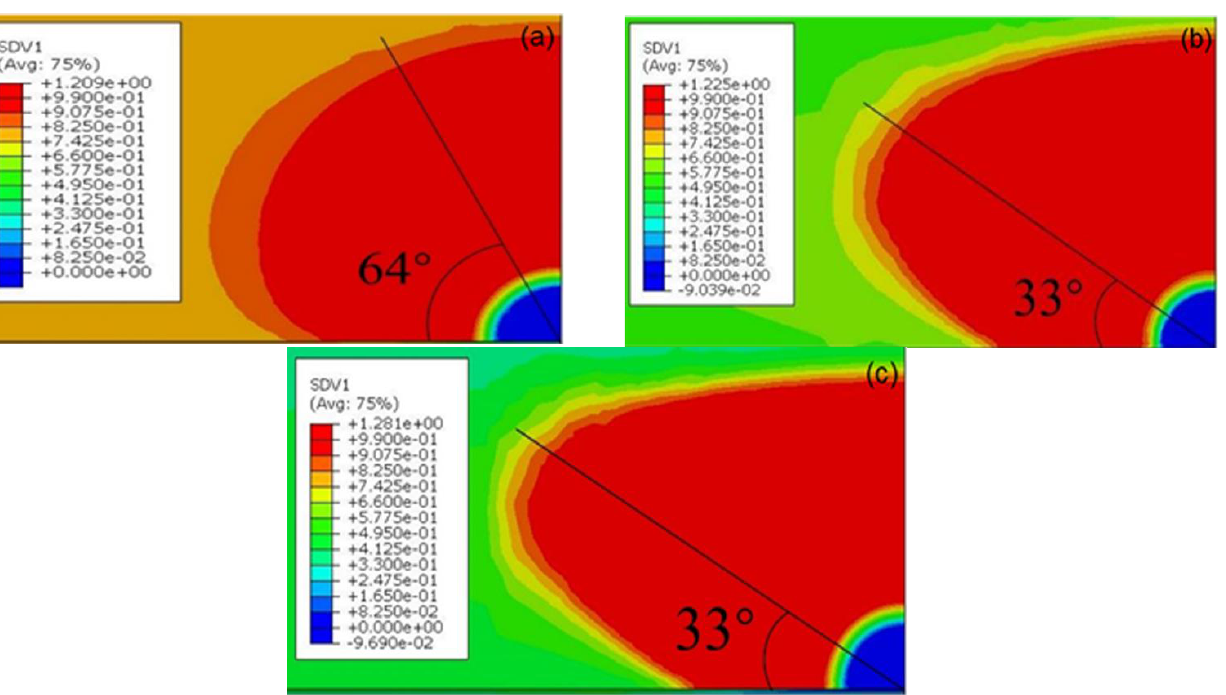
Figure 13. The distribution of the damage around the creep crack tip ( a ) p = 5 MPa, ( b ) p = 10 MPa and ( c ) p = 15 MPa.